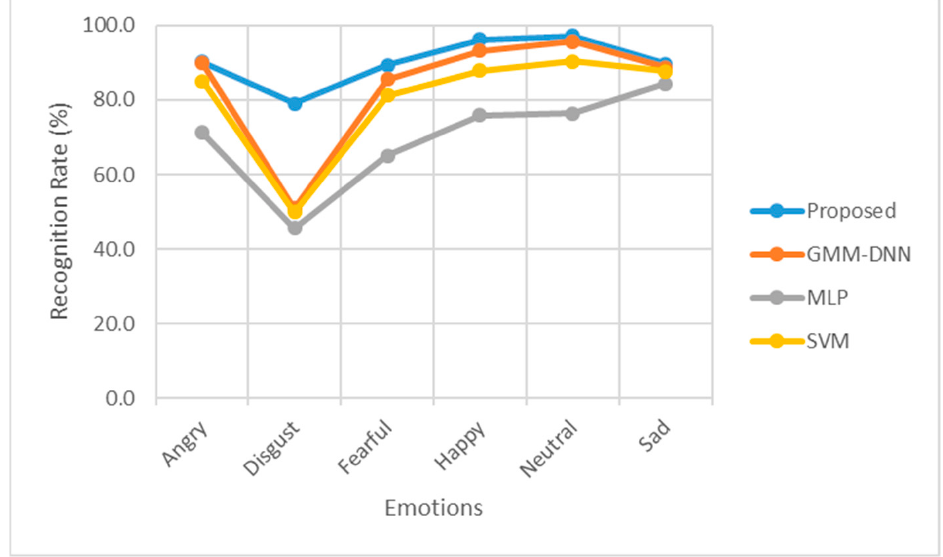
Figure 4. Emotion recognition rate obtained based on the proposed system, GMM-DNN, MLP and SVM using ESD.